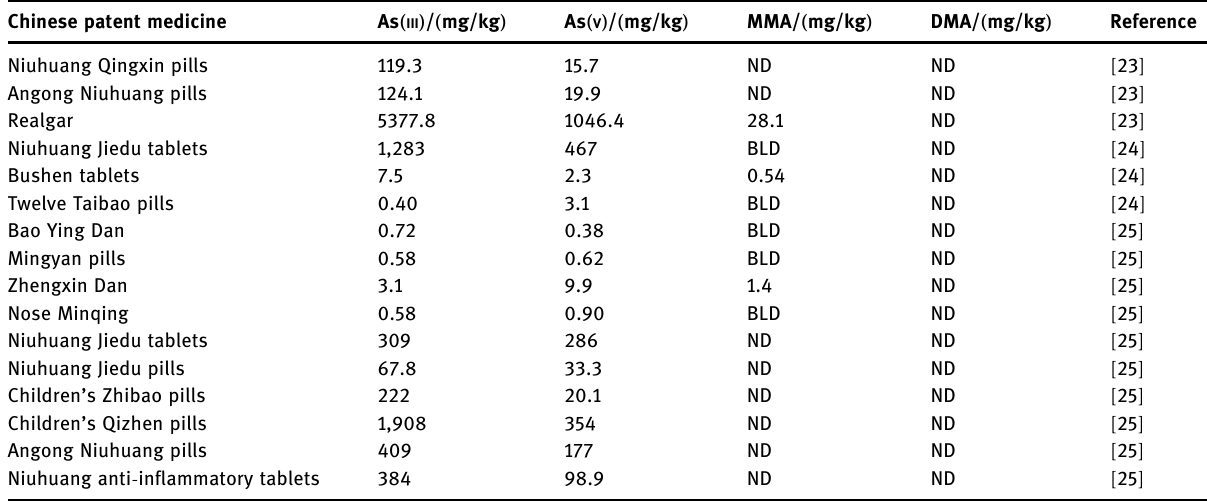
Table 3: The contents of As speciation in Chinese patent medicine Chinese patent